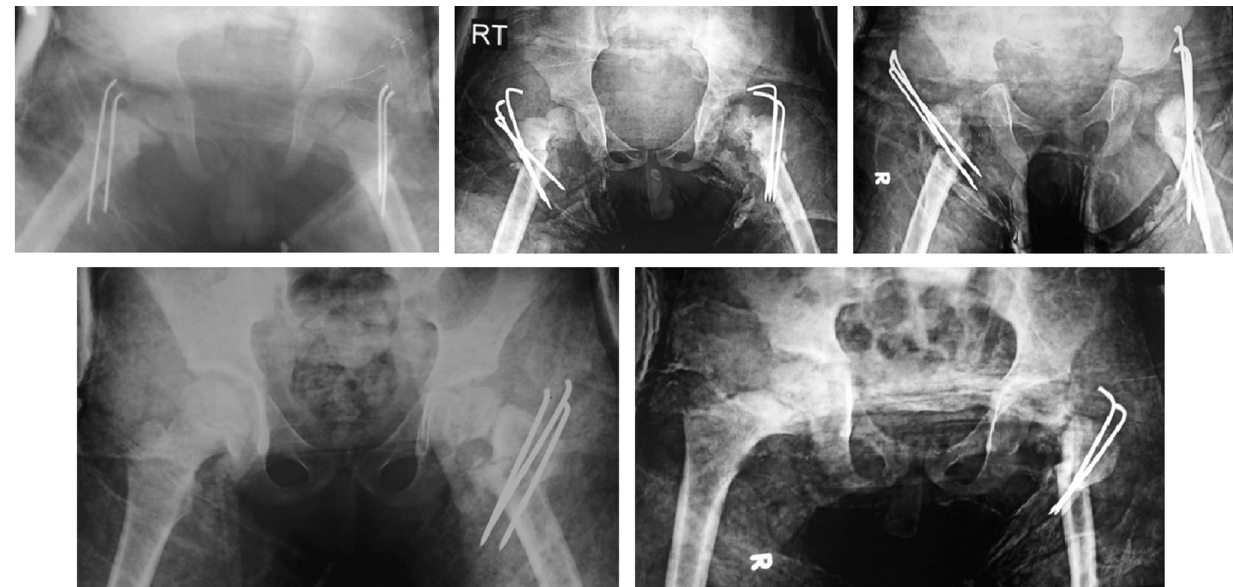
Fig. 5 Immediate-postoperative X-rays of the hip spica casts, showing the correction achieved and the osteotomy